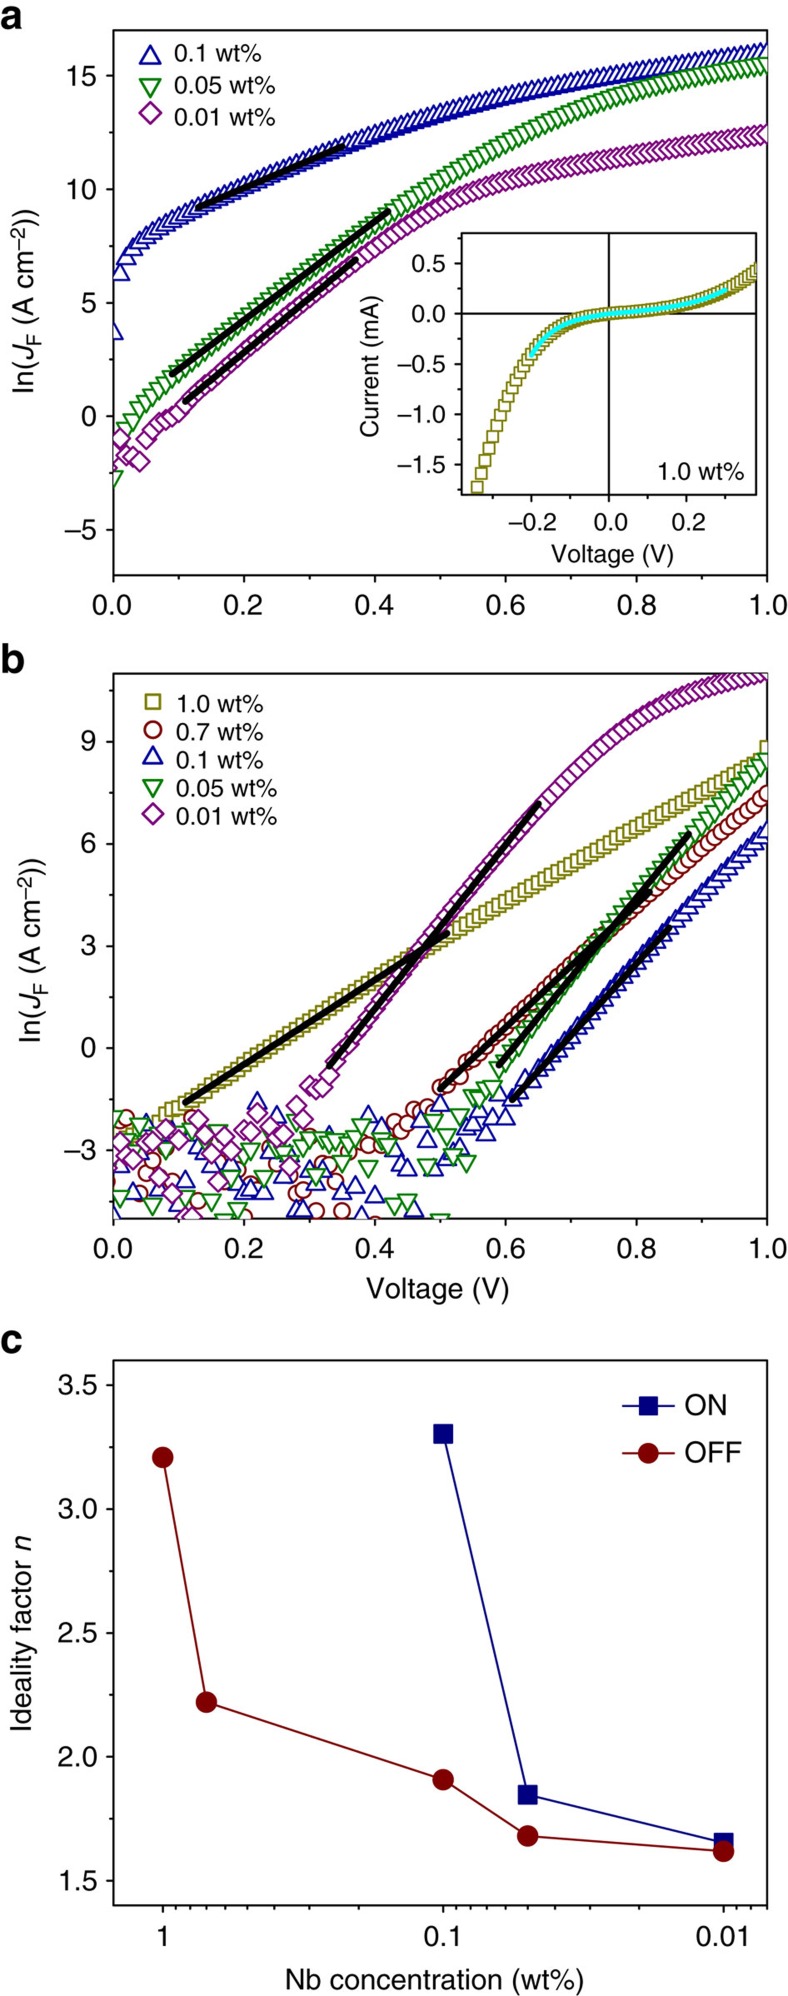
Fits to the I–V curves of Pt/BaTiO3 (BTO)/Nb:SrTiO3 ferroelectric tunnel junctions with a 4 u.c.-thick BTO barrier.(a,b) lnJF–V plots for the ON and the OFF states, respectively. The black solid lines are fits to equation (1). The inset in a is the ON state I–V curve of the junction with a Nb concentration of 1.0 wt%, where the cyan solid line is a fit to the direct tunnelling model. (c) Ideality factor n extracted from the fitting as a function of Nb concentration.